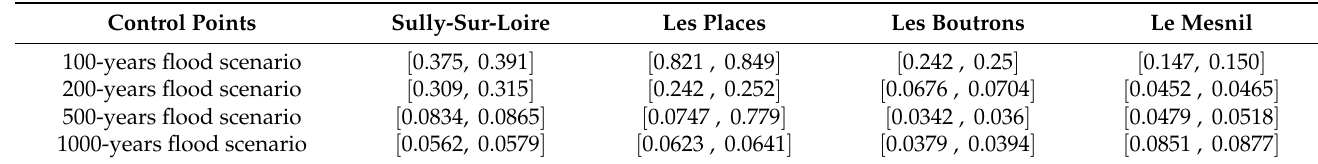
Figure 7. Convergence graphs of coefficient of variation (standard deviation to mean ration) and its 90% confidence interval according to sample size, for 100, 200, 500 and 1000-year return period flood scenarios at some control points: ( a ) Sully-Sur-Loire; ( b ) Les Places; ( c ) Les Boutrons; ( d ) Le Mesnil. Table 3. 90% confidence intervals of the coefficient of variation obtained from the Monte Carlo sample set of 3000 computations for 100, 200, 500 and 1000-year return period flood scenarios at some control points.